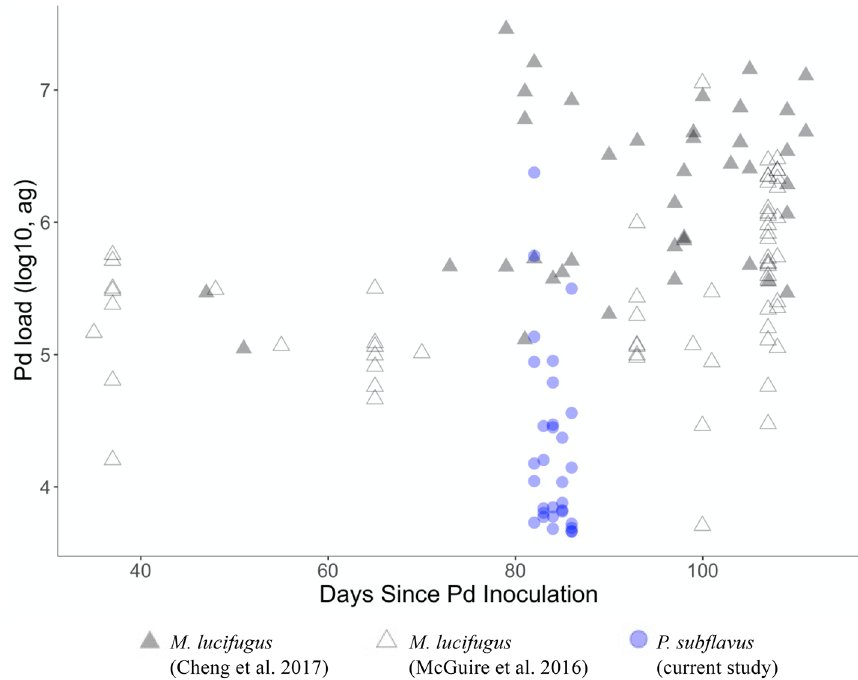
Figure 5. Comparison of fungal loads of Pseudogymnoascus destructans ( Pd ) measured on little brown bats ( Myotis lucifugus ) and tri-colored bats ( Perimyotis subflavus ) in experimental infection trials using the same experimental inoculation